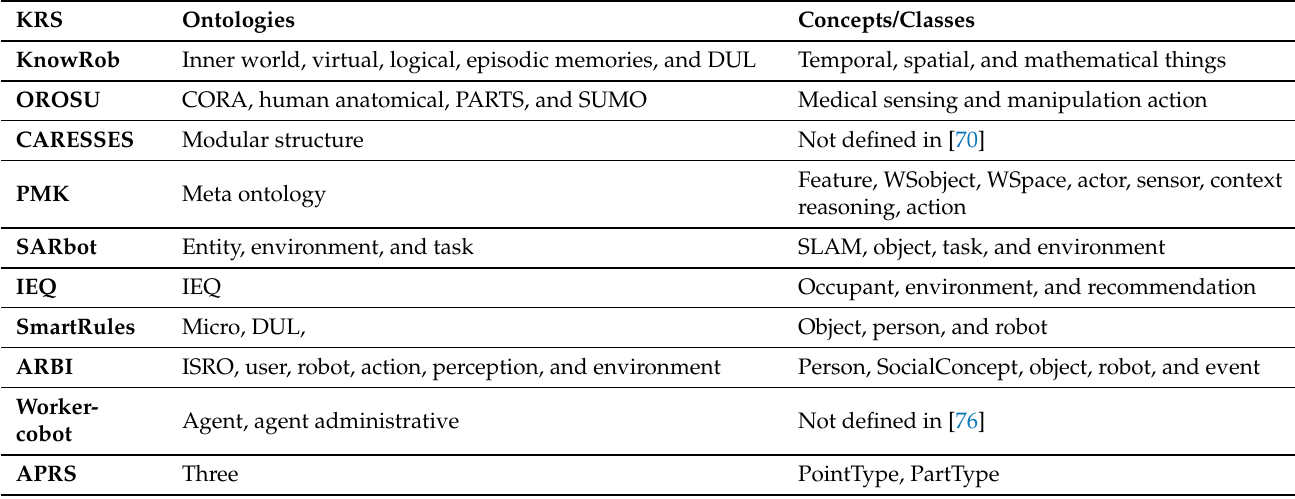
Table 7. KRSs: ontology